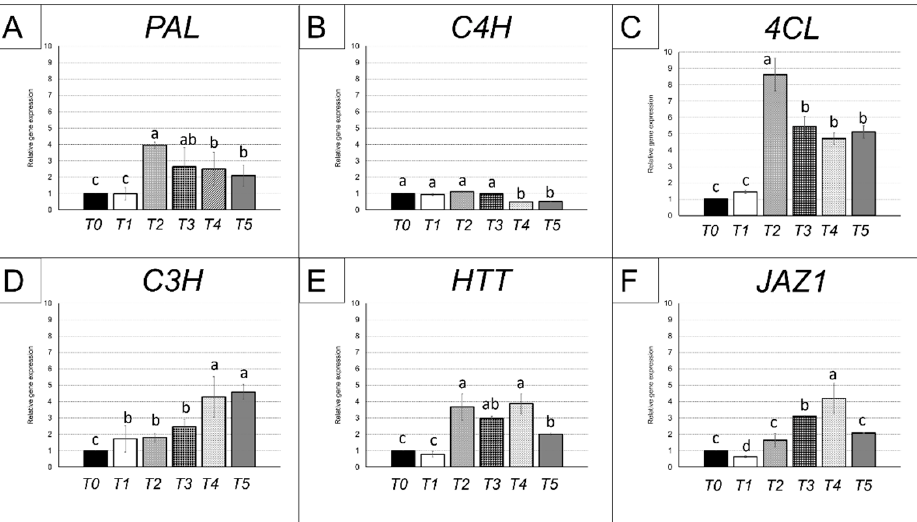
Figure 4. Expression analysis of genes involved in chicoric acid biosynthesis ( A – E ) and methyl- jasmonate signaling ( F ) on Echinacea purpurea cell suspensions, firstly grown in the maintenance liquid medium (T0-T1) and then in the productive liquid medium (T2-T3-T4-T5) for 21 days. After T2, MeJa was supplied to elicit chicoric acid biosynthesis. Data are mean ± SE for three biological replicates. Different letters above the bars indicate statistically significant differences at p < 0.05 for ANOVA. The expression levels of genes are presented using mRNA levels normalized to ACT